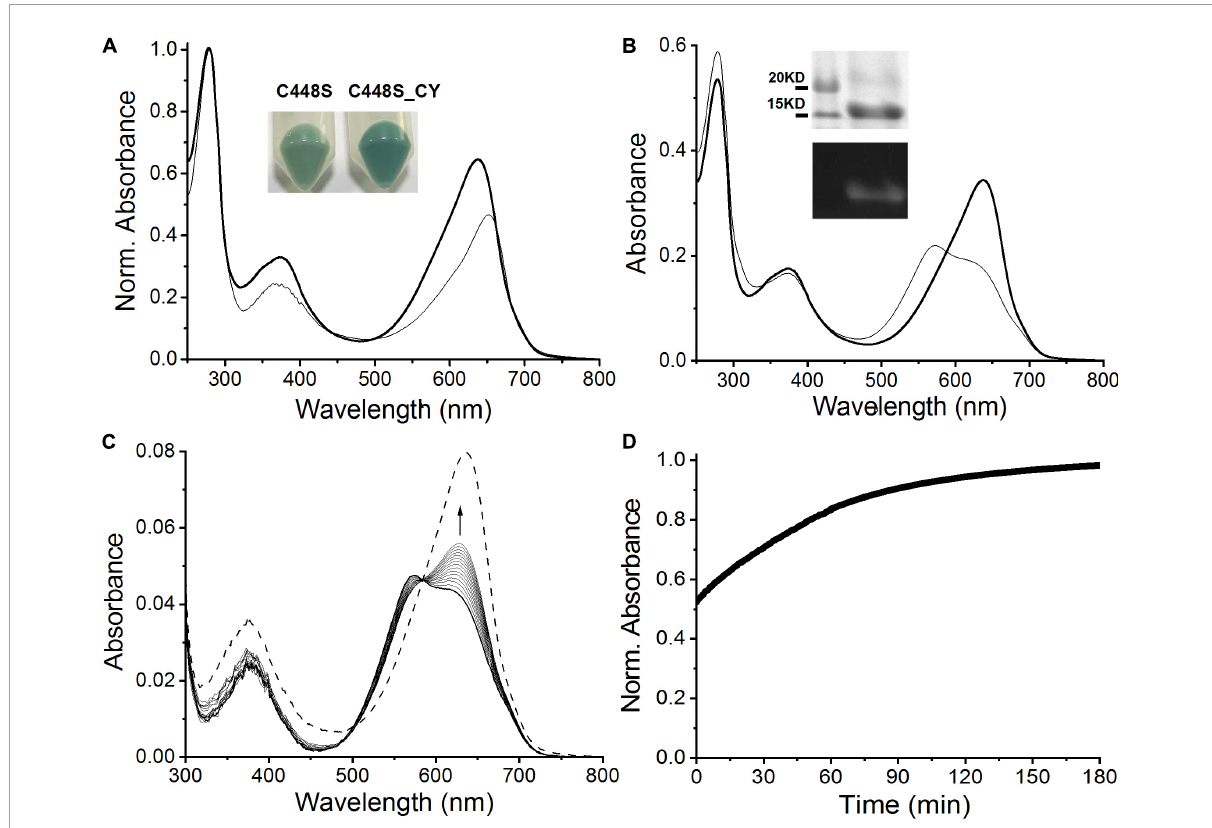
FIGURE4 Characterization of C448S_CY. (A) Absorbance spectra of C448S_CY (heavy solid line) and C448S (thin solid line) as a control. Protein absorbance values at 280 nm were adjusted to be equal. In the inset, the color of E. coli cell pellets is shown for expressed C448S_CY (right) and C448S (left) as a control. (B) Photoconversion of C448S_CY. The thin solid line corresponds to the 15E state obtained after irradiation with 653/20 nm light. In the inset, the total protein (up) and covalently bound bilin (down) are shown for purified C448S_CY. (C) Absorbance spectra of C448S_CY acquired at the indicated times after irradiation. The dashed line indicates absorbance spectra of the 15Z state obtained before irradiation. (D) Normalized absorbance at 638 nm monitored after driving the biliprotein to the